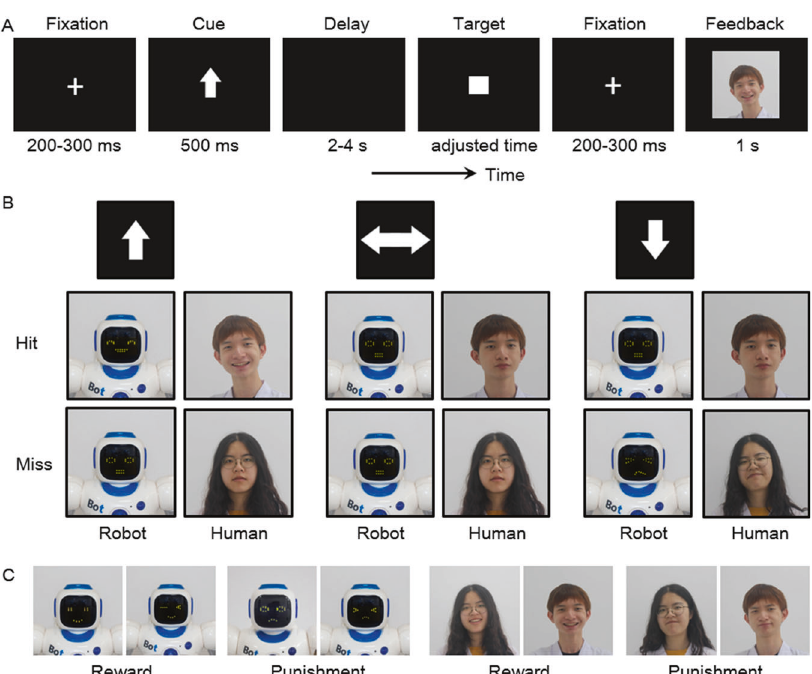
Fig. 1 Experiment programs. A An exemplar trial in the reward condition. B The relationship between each kind of cue and feedback (for hits or misses). The two undergraduate students in the picture were from the fi rst author DZ ’ s research group and have given their consent for these materials to appear in academic journals. C Examples of all kinds of positive and negative